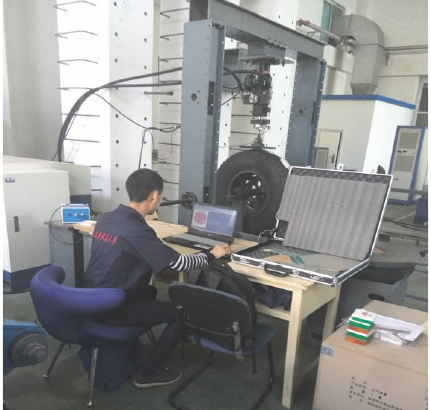
Figure 8: Testing for tire